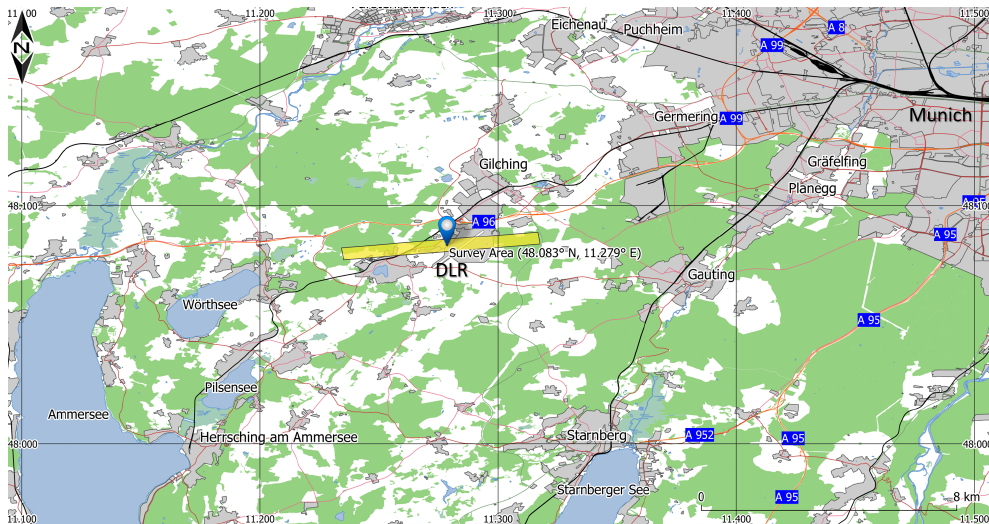
Figure 3. Survey area located on DLR premises close to Munich, Germany. Relevant flight line and location of the deployed synthetic targets are